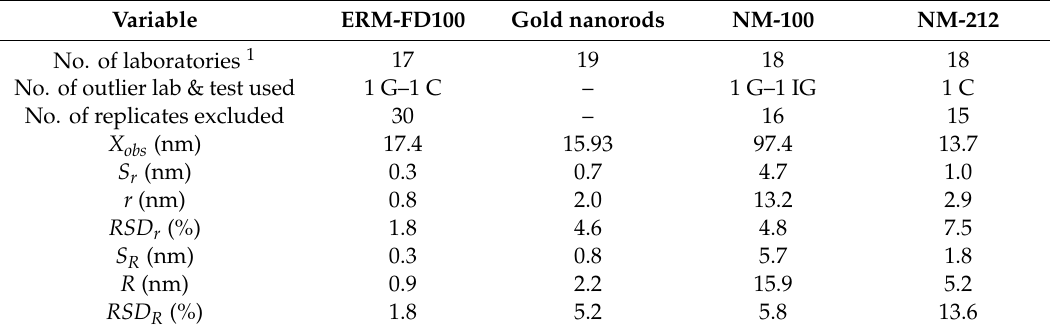
Table 5. Method performance characteristics computed according to ISO